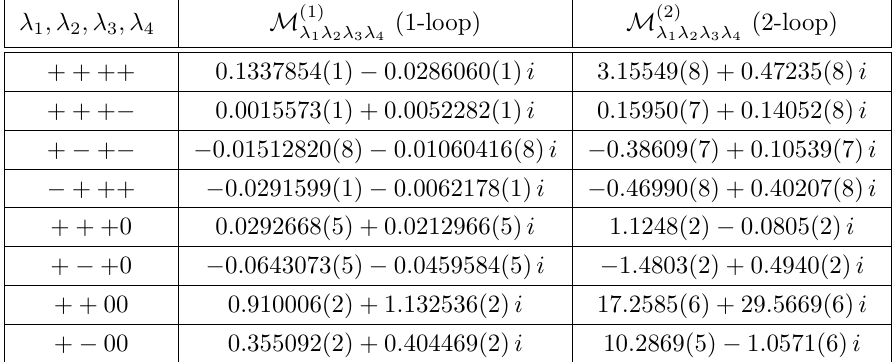
= 142 / 17 , t/m 2 = − 125 / 22 , m 2 = 5 / 18 , /m 2 t t t Z